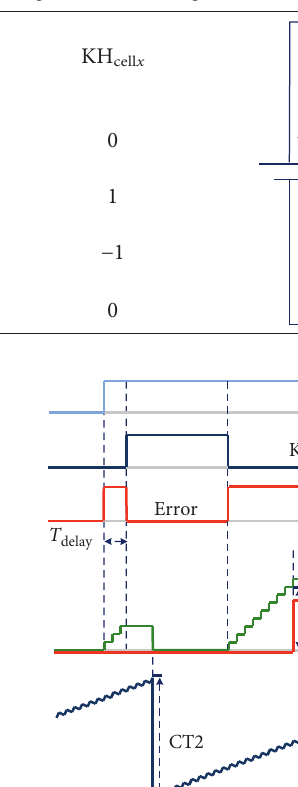
Figure 5: Block diagram of the proposed fault detection method. Table 2: Relationship between output voltage and control signal of cell x .